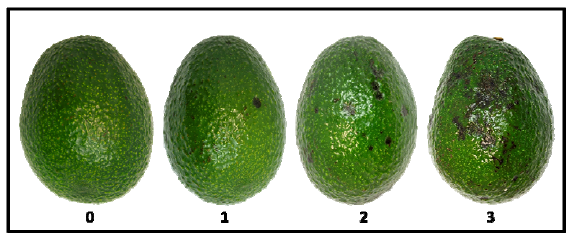
Figure 2. Hedonic scale for black spot severity: 0 = fruit without damage, 1 = fruit with damage less than 25%, 2 = fruit with damage greater than 25% but less than 50% and 3 = fruit with damage greater than 50% damage. Own elaboration.